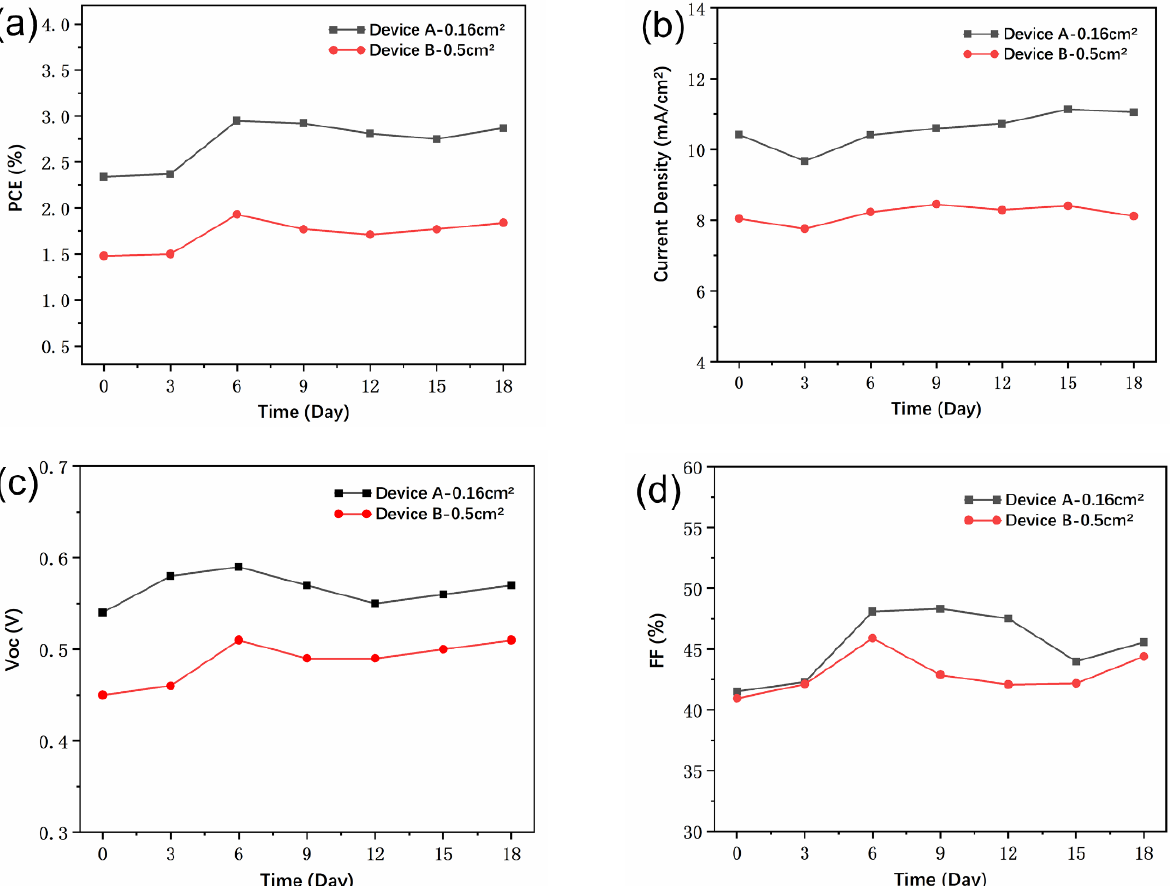
Figure 6. Evolution of parameters ( a ) PCE (power conversion efficiency), ( b ) J sc , ( c ) V oc , and ( d ) FF for devices with different active areas stored under ambient conditions (Device A—0.16 cm 2 , Device B—0.5 cm 2 ).